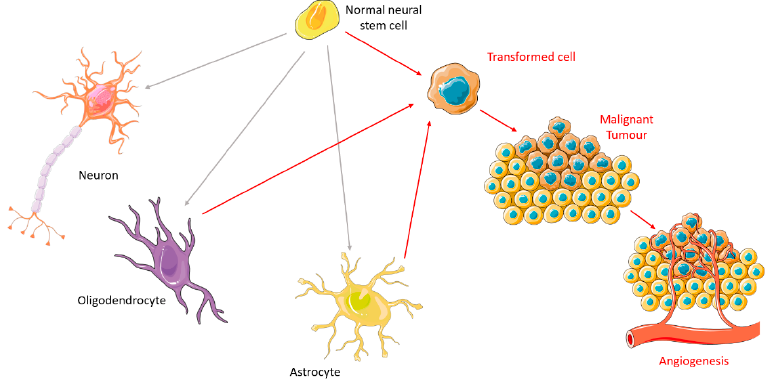
Figure 1. Carcinogenesis in brain cells. Figure drawn with smart.servier.com.